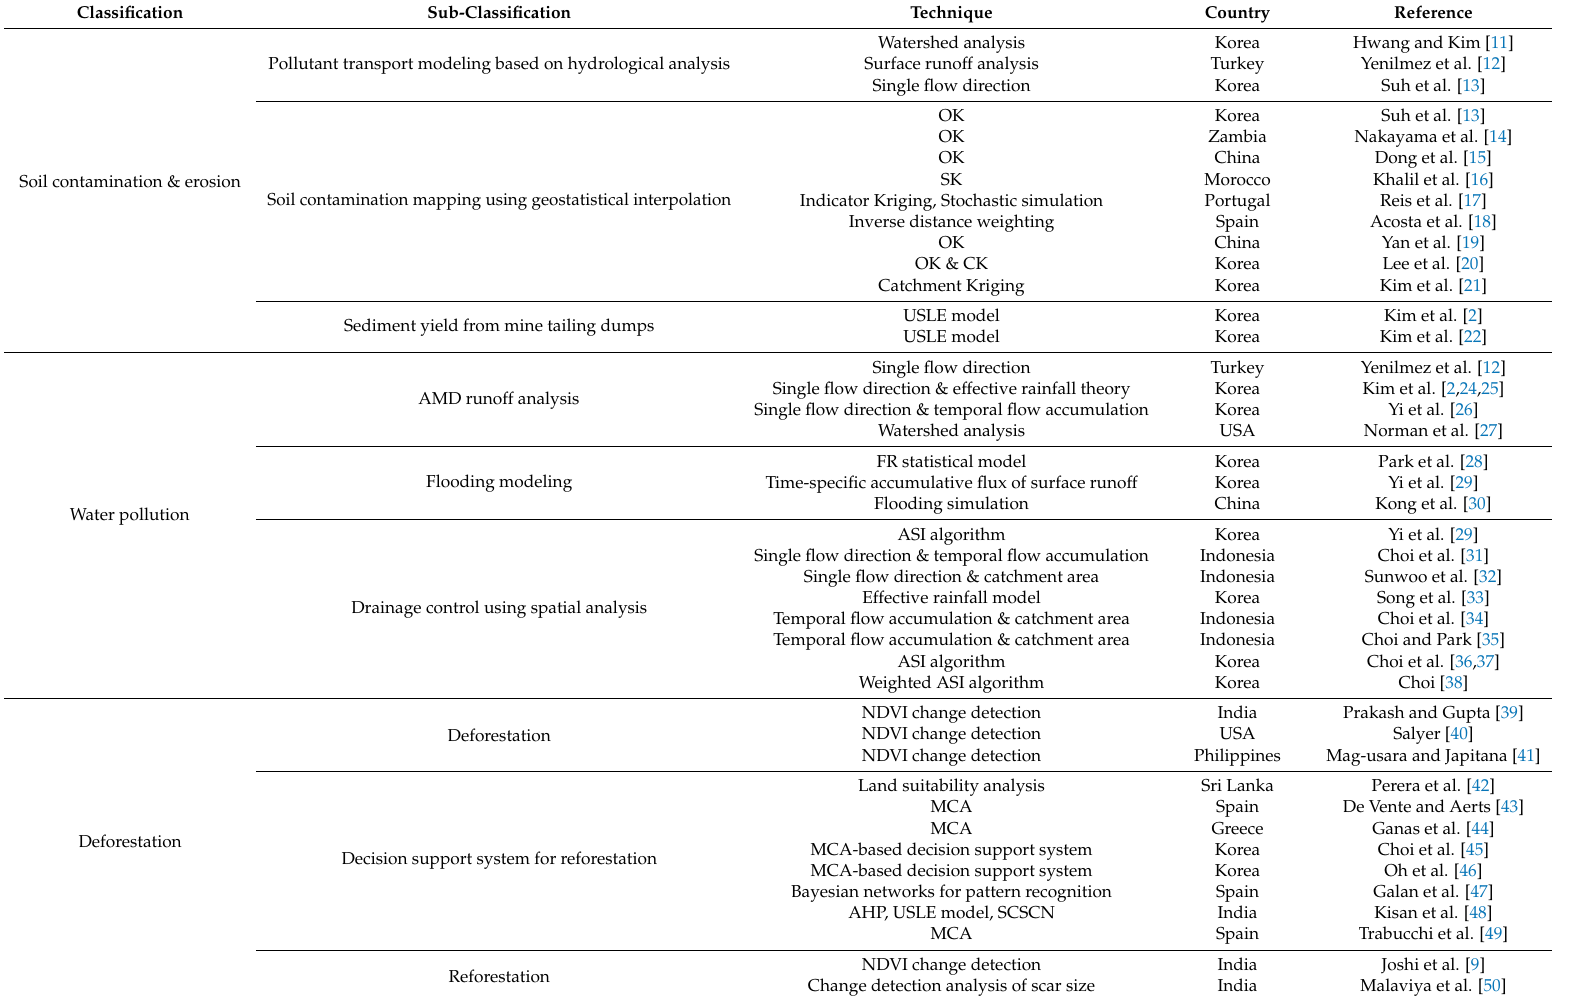
Table 2. Classification and summary of research concerning GIS-based modeling and assessment of mining-induced hazards associated with soil, water and forest.